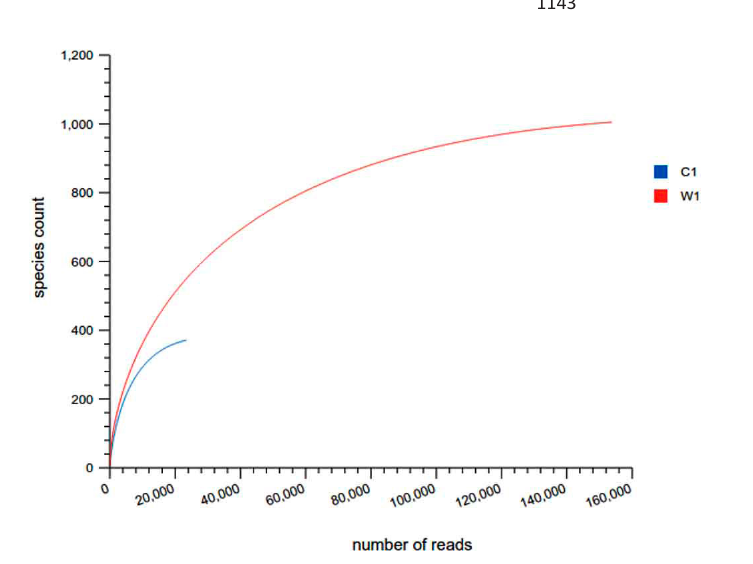
Fig. 17. Rarefaction curves Note: The X axis is the number of Species, and the Y axis is the number of OUT reads. Each sample is represented by one curve with a unique color.